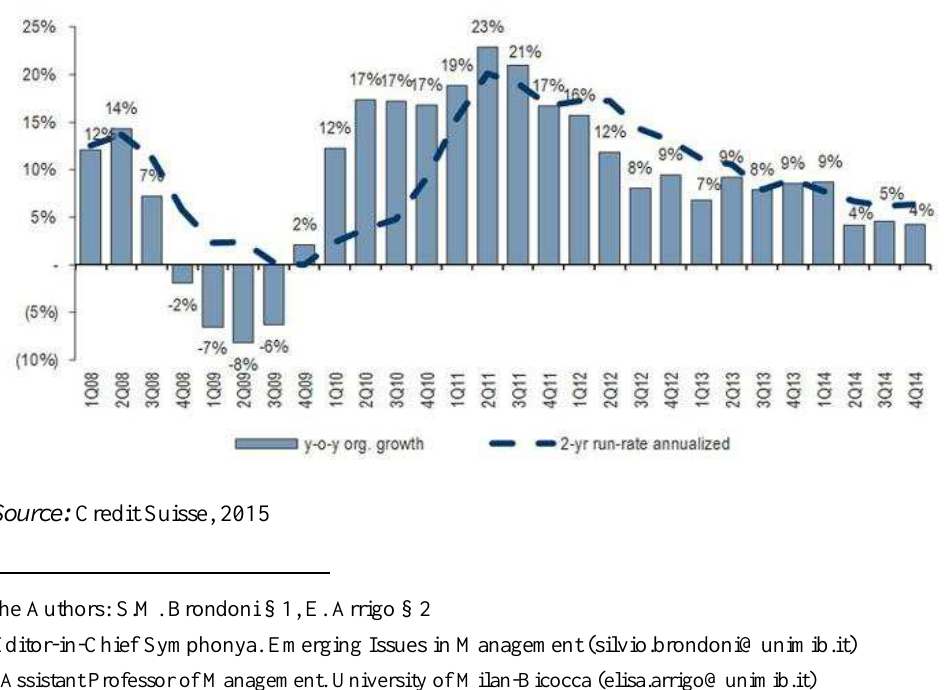
Figure 1: Development of the Luxury Goods Sector